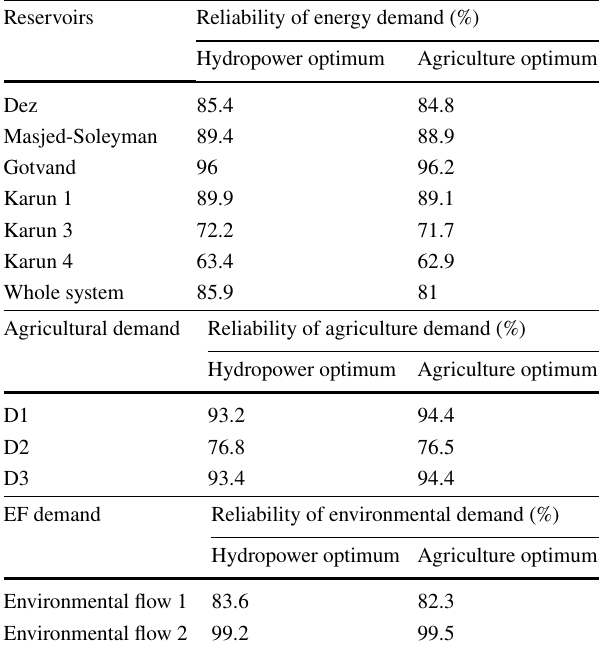
Table 2 Reliability of the system in two extreme points of scenario 1 Reservoirs